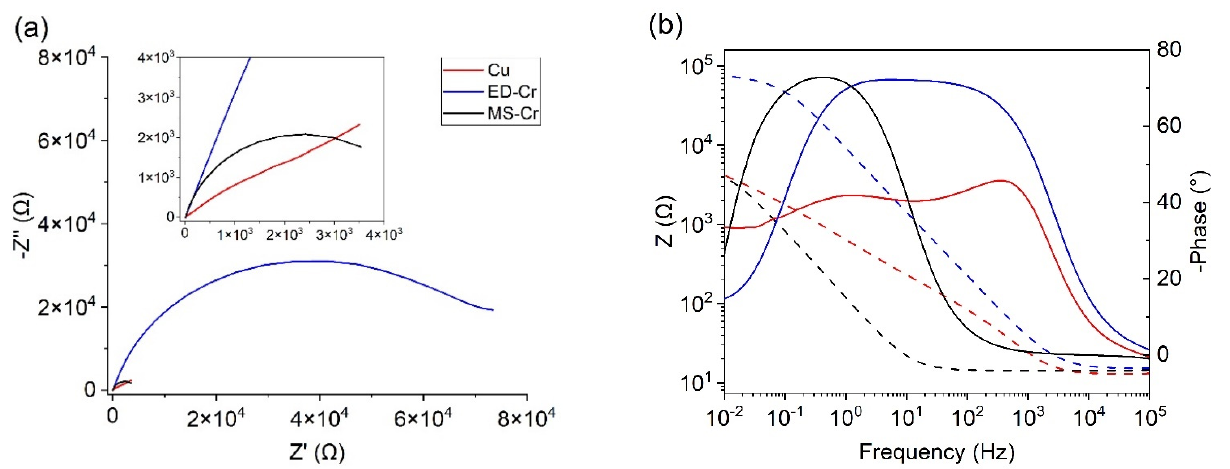
Figure 8. EIS data represented as Nyquist plot ( a ) and Bode phase plots ( b ) obtained in aerated 3.5% NaCl solution at room temperature. Samples as in the legend. Inset in the Figure 8a depicts a zoomed view of Nyquist plot. Table 2. Electrochemical corrosion data.